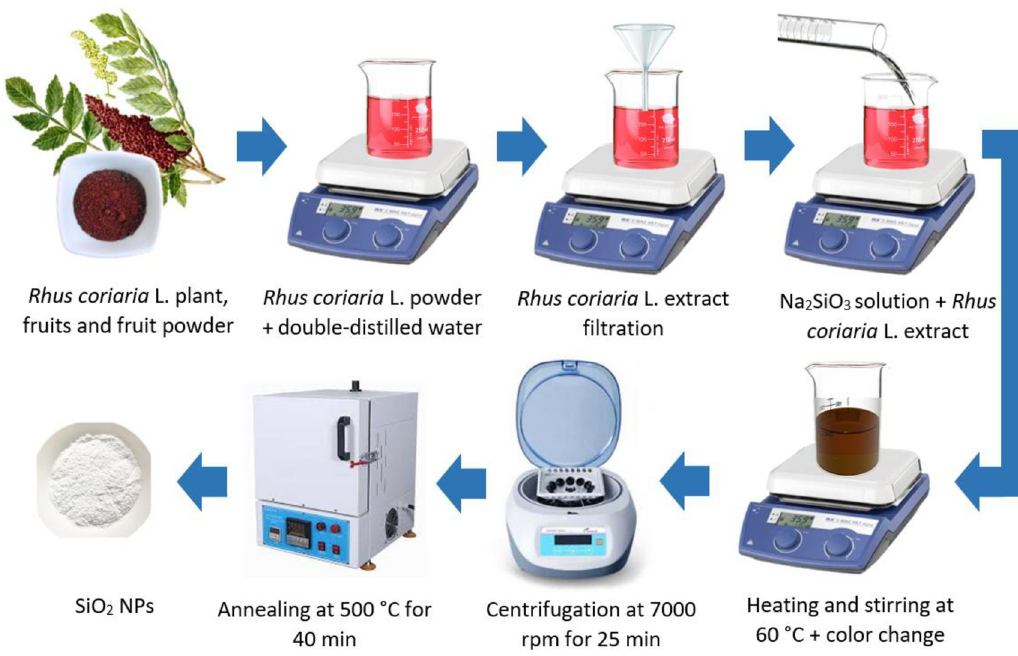
Fig 3. Schematic diagram of the green synthesis process of SiO 2 NPs using Rhus coriaria L. extract.